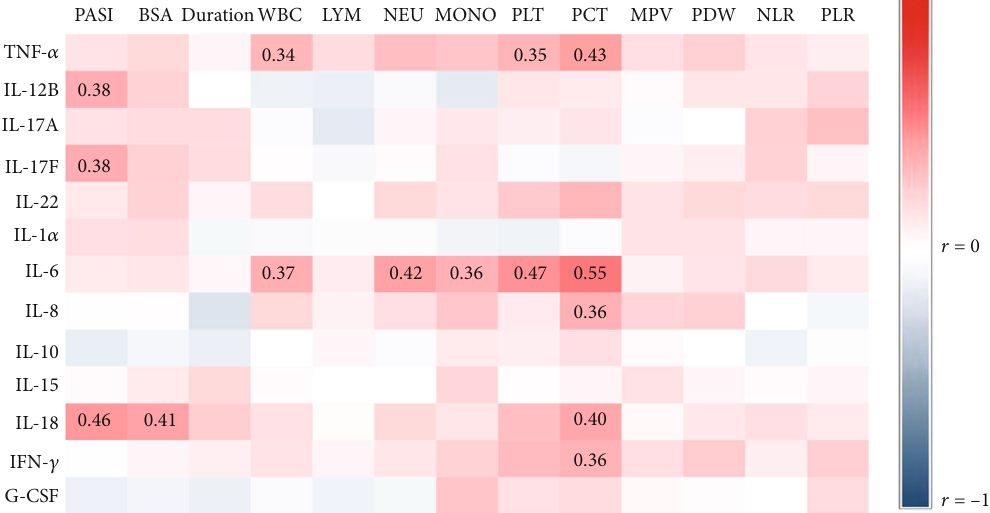
Figure 2: Correlation of serum cytokines with clinical parameters in psoriasis patients. Correlations of serum cytokines with PASI, BSA, duration ( n = 44 ), and the absolute number of white blood cell (WBC), lymphocyte (LYM), neutrophil (NEU), monocyte (MONO), platelet (PLT), plateletcrit (PCT), mean platelet volume (MPV), platelet distribution width (PDW), neutrophil-lymphocyte ratio (NLR), and platelet-lymphocyte ratio (PLR) ( n = 34 ) are analyzed by Spearman ’ s correlation. Positive correlations are shown as red and negative as blue. The intensity of color is proportional to the correlation coe ffi cients. Statistically signi fi cant r values ( p < 0 : 05 ) are given in the corresponding rectangle.